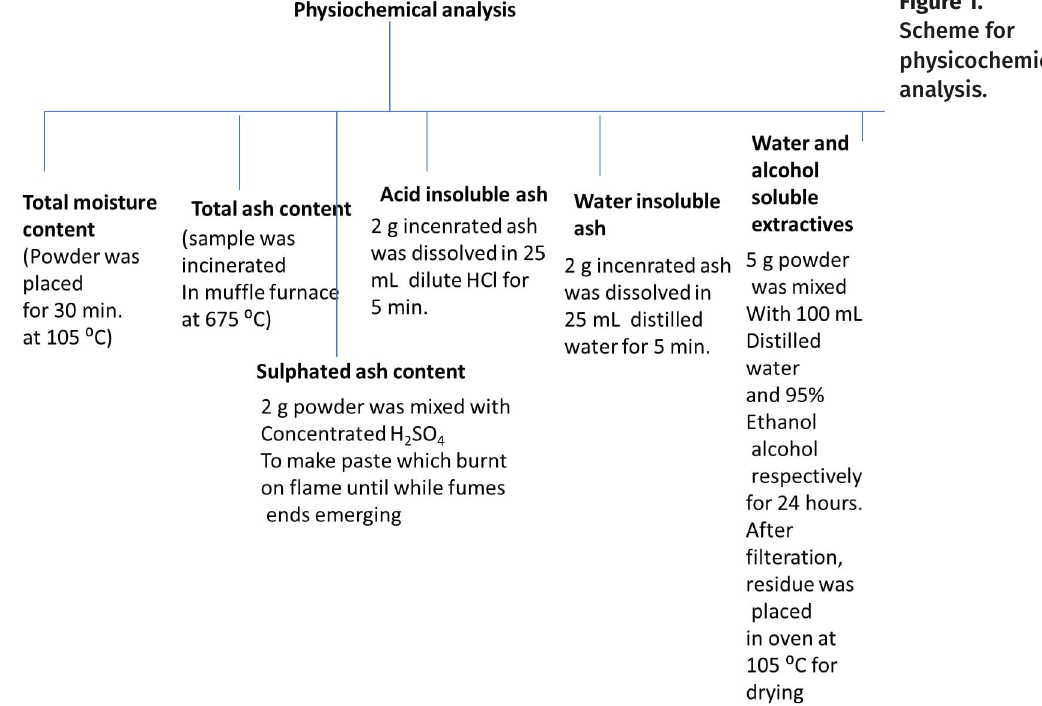
Figure 1. Scheme for physicochemical